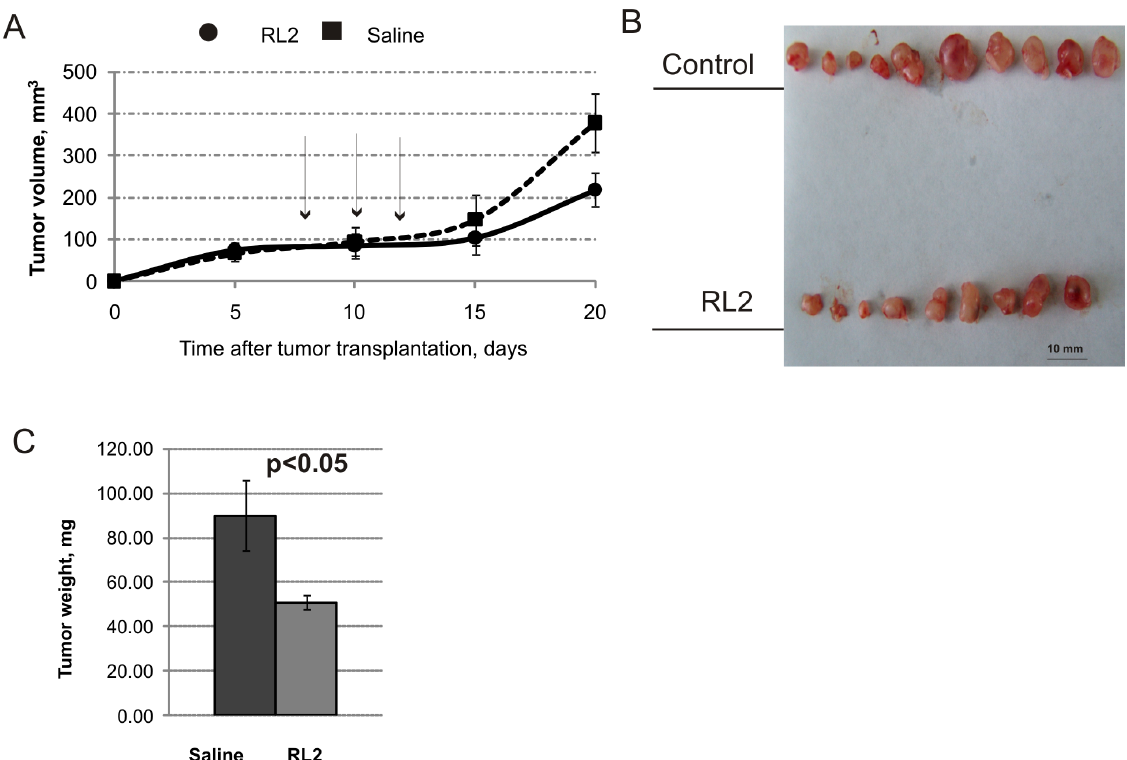
Figure 7. RL2 therapy delays tumour development. Female SCID mice aged 3–4 weeks old were used for s.c. MDA-MB-231 cell transplantation. RL2 (40 mg/kg) dissolved in saline was administered i.v. via the tail vein every second day starting on day 8 after tumour transplantation. A . The growth rate of MDA-MB-231 tumours. Arrows indicate the days on which RL2 was injected. B : Tumours were excised on day 20 and photographed. C . Statistical difference in mean tumour weight between control and experimental groups was p , 0.05 (statistically significant differences between groups). Data are presented as mean tumour (g) 6 SE.